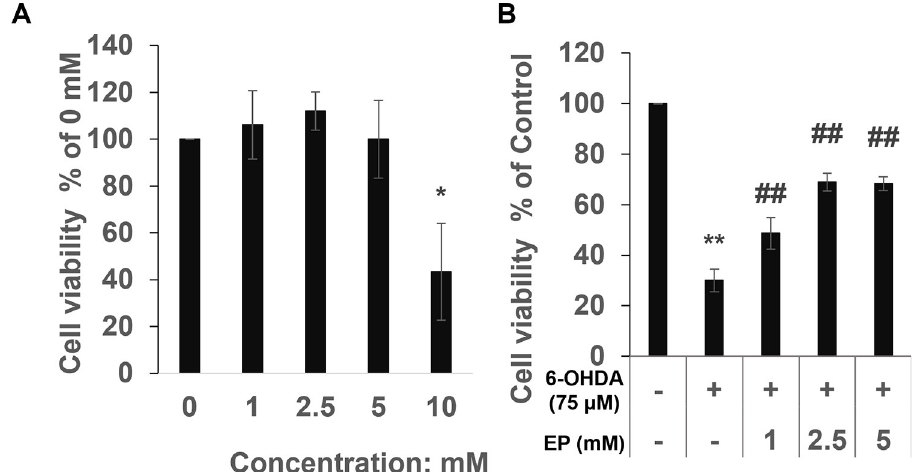
Fig 1. Effects of EP on cytotoxicity induced by 6-OHDA. (a) Cytotoxicity of EP. (b) Effects of EP on 6-OHDA- induced cell death determined as cell viability using MTT assays. Results are expressed as means ± standard deviation (N � 3), � P < 0.05, † P < 0.01 vs . controls; ‡ P < 0.01 vs . 6-OHDA.